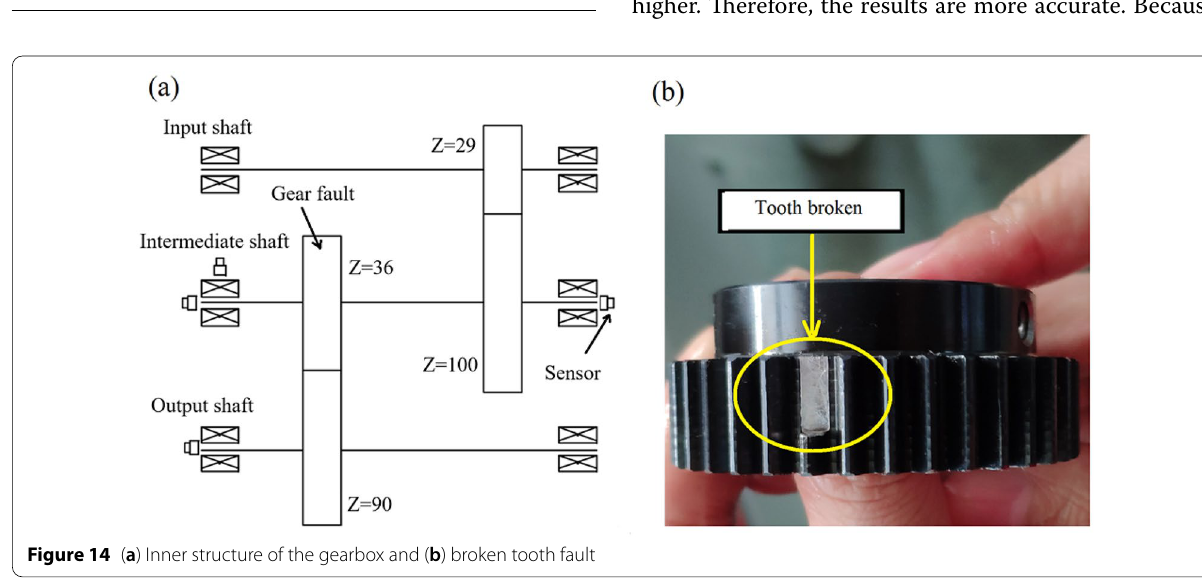
Figure 14 ( a ) Inner structure of the gearbox and ( b ) broken tooth fault